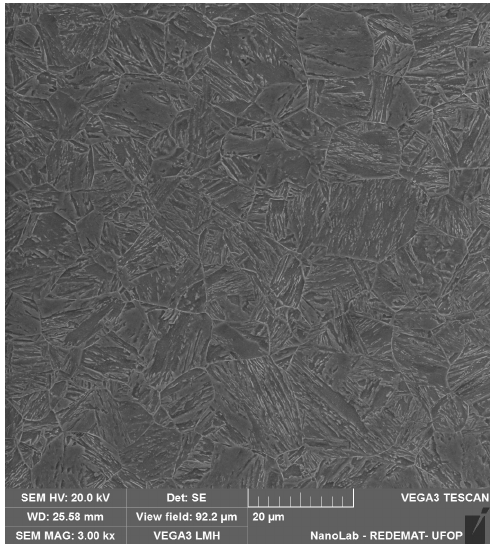
Figure 5. Microstructure of the studied steel austenitized at 920°C and cooled at 25°C/s rate. Nital 2%. 3000x.